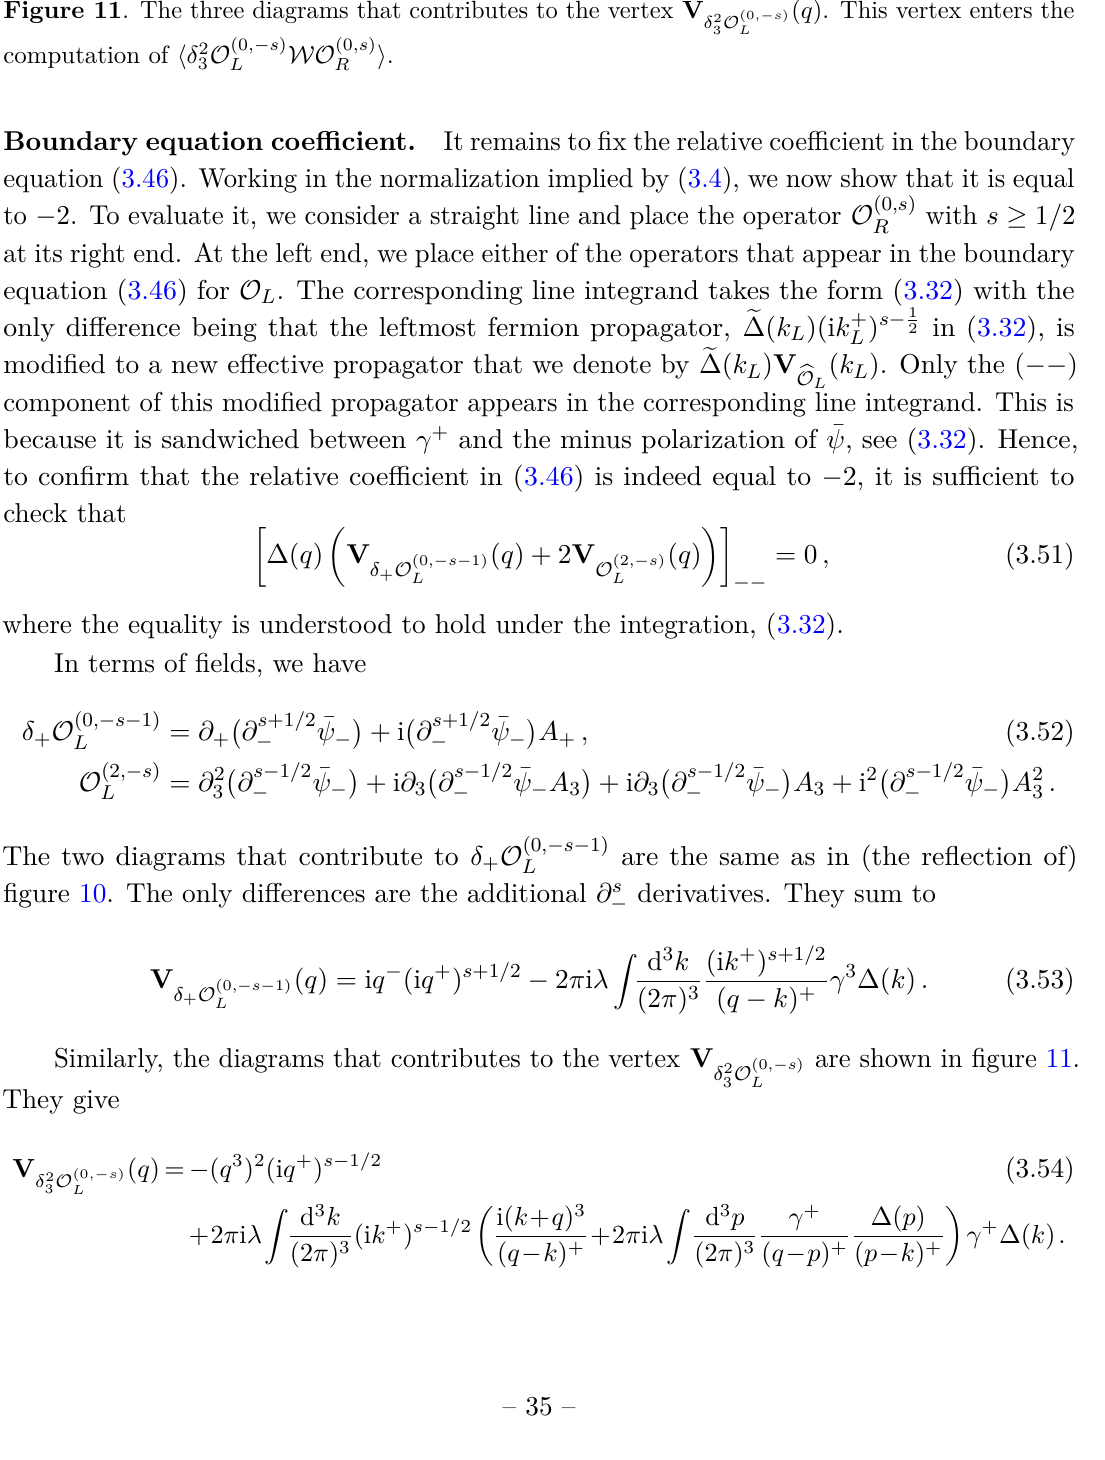
( q ) . This vertex enters the δ 2 3 O (0 , − s ) L